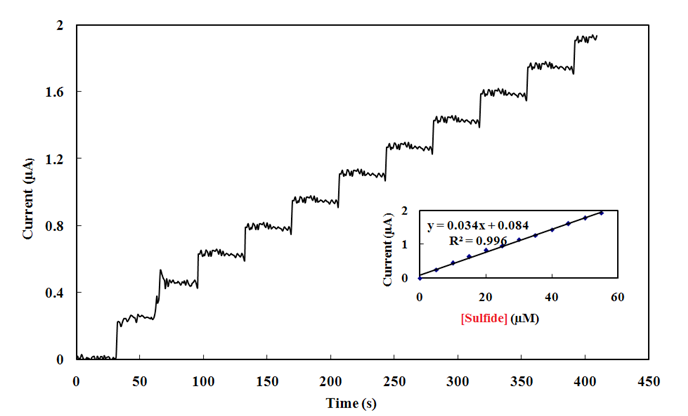
Figure 9. Amperometric response at a rotating modified Cu-complex/ MWCNTs/ GCE (the rotation speed is 1000 rpm) held at 0.47 V in pH = 8 solution for successive addition of 5.0 μM total sulfide. Inset: plot of chronoamperometric current response vs. total sulfide